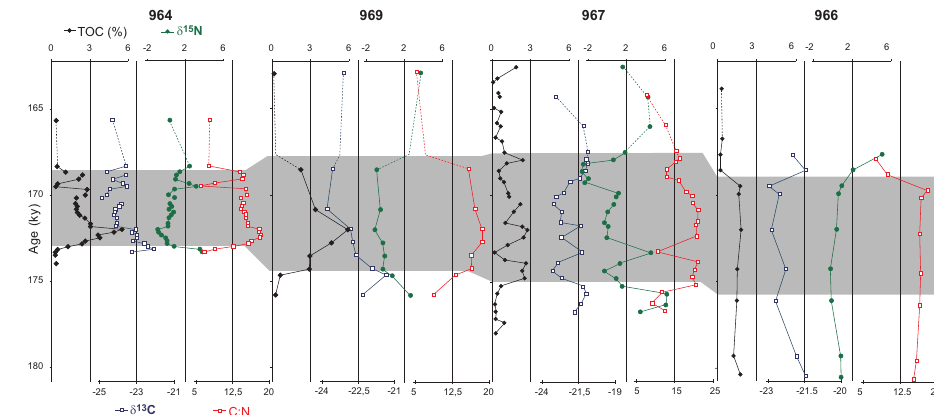
Fig. 9. TOC, C and N ratio, d 15 N, d 13 C for S6 at all studied sites. Shaded area corresponds to organic enriched sediments.